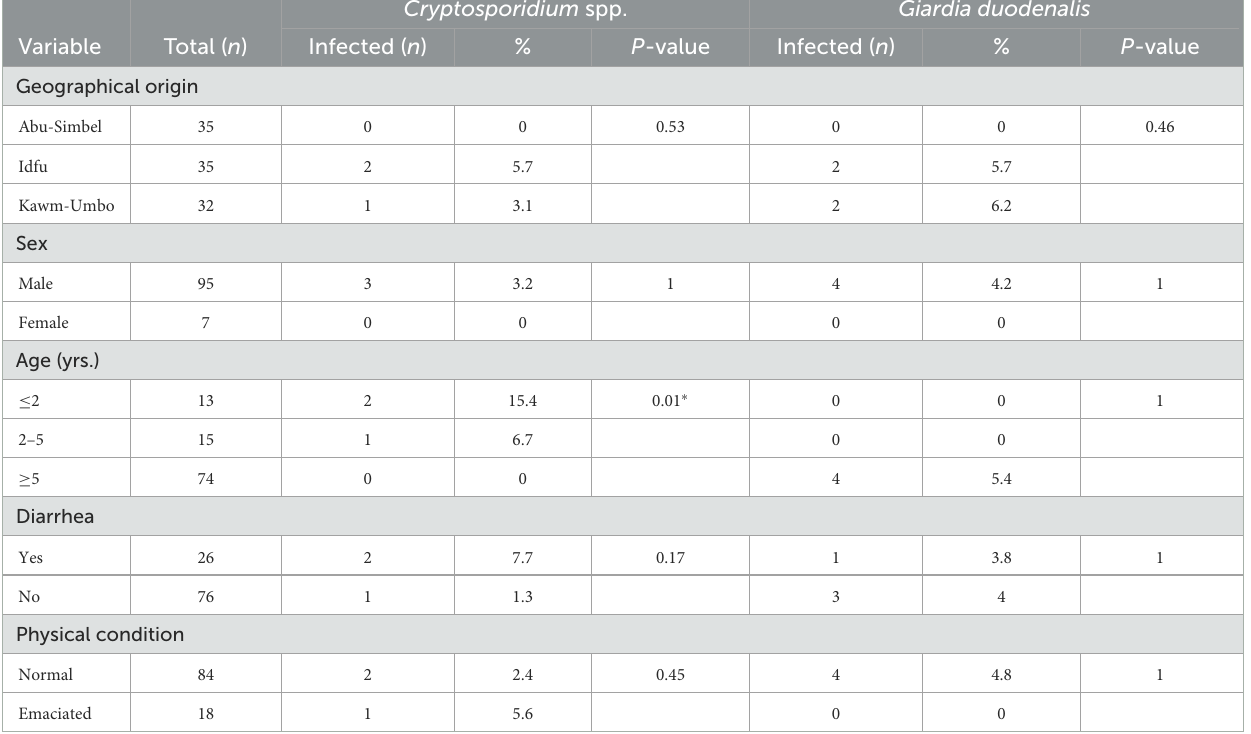
TABLE 2 Distribution of Cryptosporidium spp. and Giardia duodenalis infections according to geographical origin, sex, age, fecal consistency, and physical condition of examined camels ( n = 102). Cryptosporidium spp.